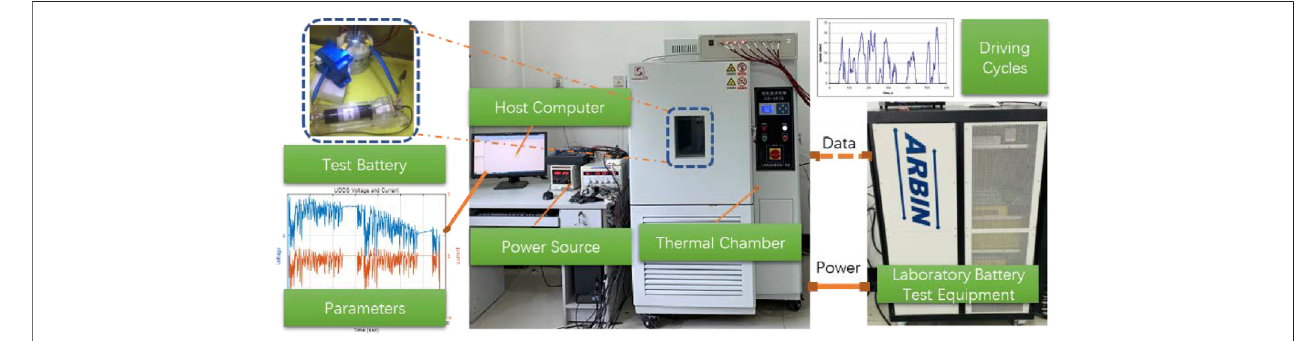
FIGURE 1 | Schematic diagram of the experimental setup.